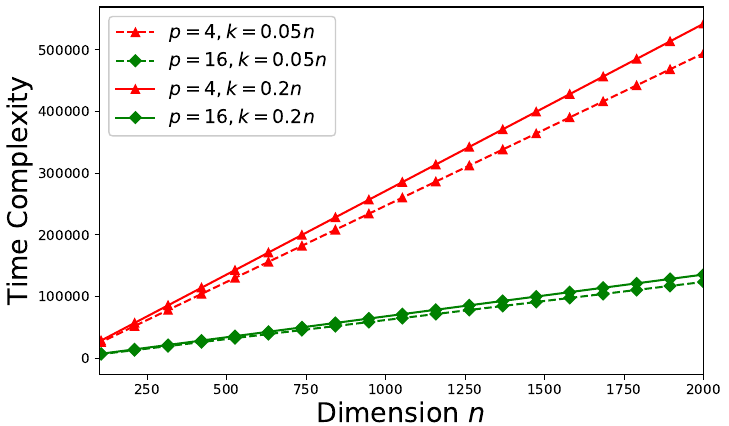
Figure 8. Time-complexity versus the number of processors p and the dimension k subject to (cid:101) = 10 − 5 for an arbitrary consistent system ( m = 1.25 n